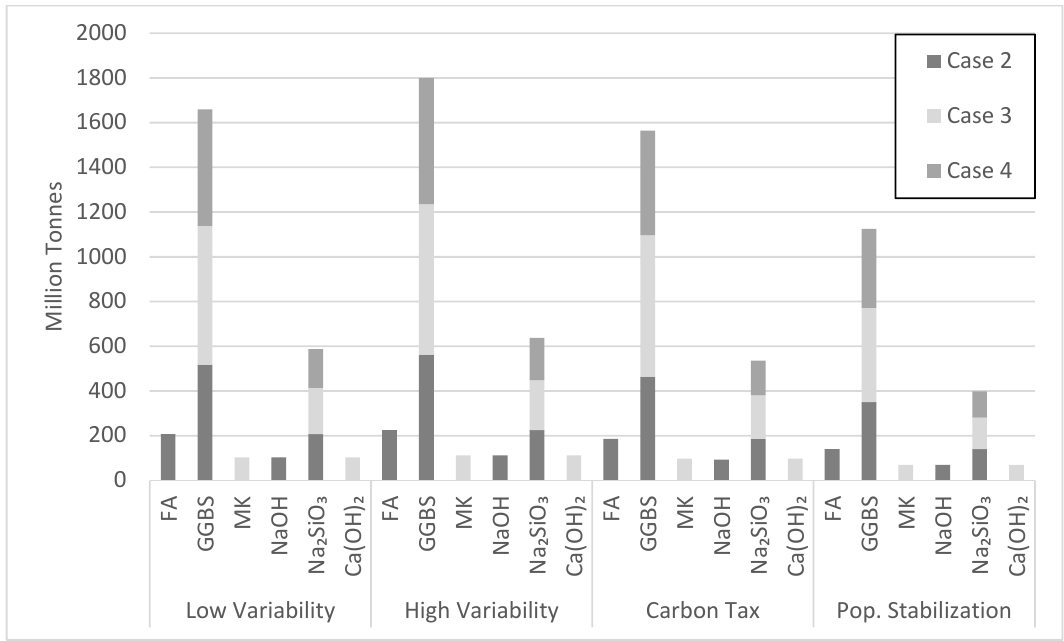
Figure 18. Projected amount of precursor and activator consumed in the year 2050.